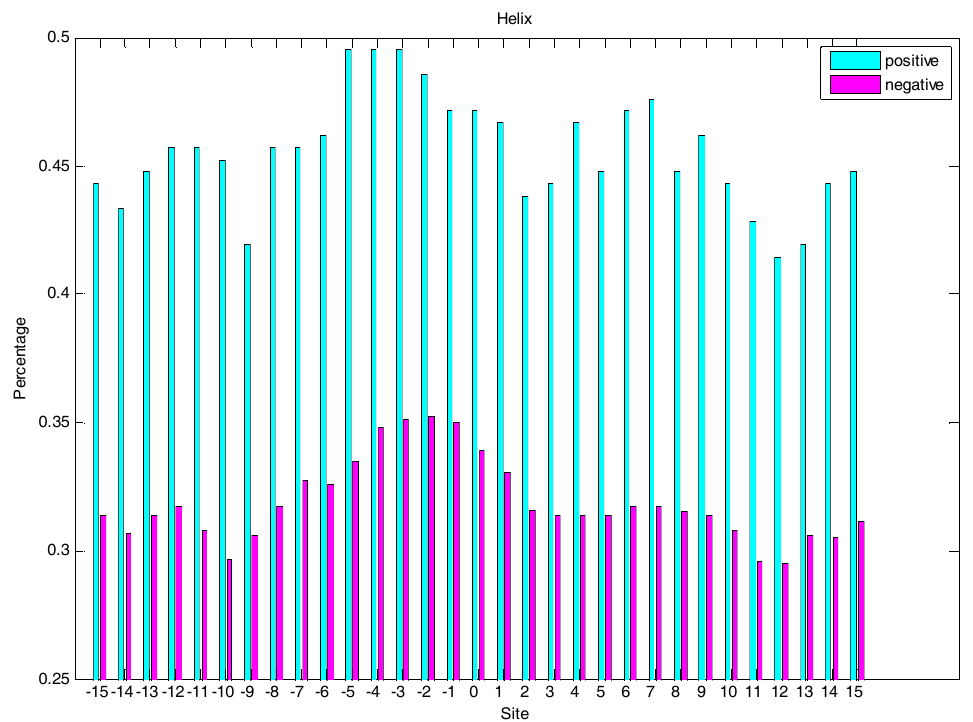
Figure 5. The distribution of helix structures of residues around glycation and non-glycation sites.